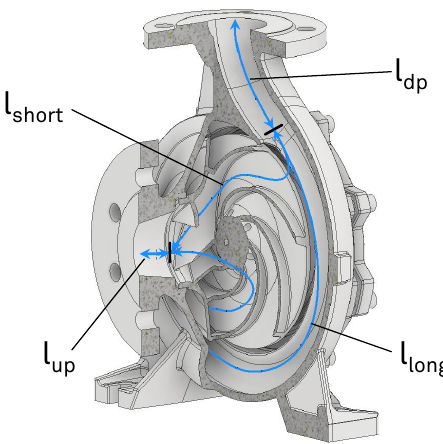
Figure 6. Illustration of the relevant acoustical lengths in a CAD